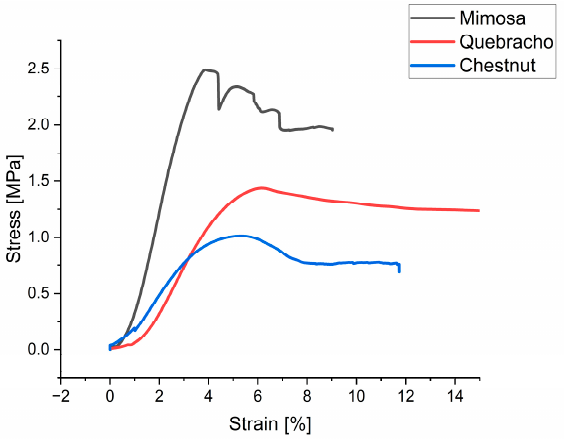
Figure 4. Mimosa—1% (239 kg/m 3 ); quebracho—10% (257 kg/m 3 ); chestnut—10% (255 kg/m 3 ).